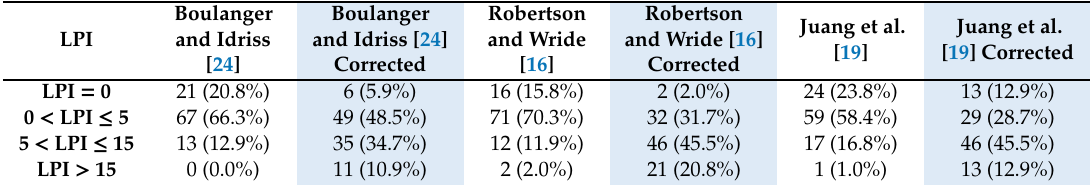
Table 7. Liquefaction severity classes for the macro-area of Versilia (CPTs with depth ≥ 15 m).